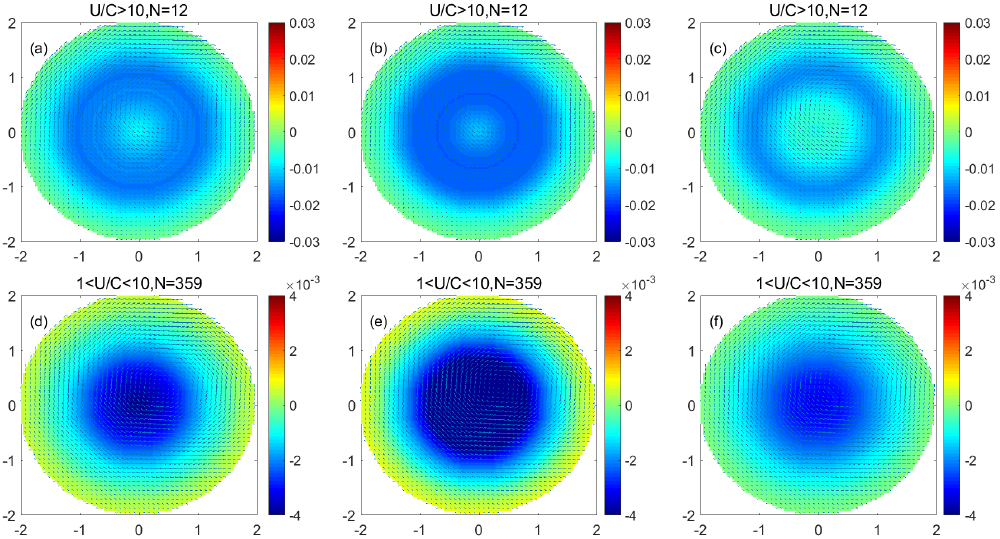
Figure 8. ( a − c ) are the monopole distribution of microplankton, nanophytoplankton, and picophytoplankton in a high nonlinear anticyclonic eddy, respectively; ( d − f ) are the monopole distribution of microplankton, nanophytoplankton, and picophytoplankton in a low nonlinear anticyclonic eddy, respectively. (Unit: mg/m 3 ).